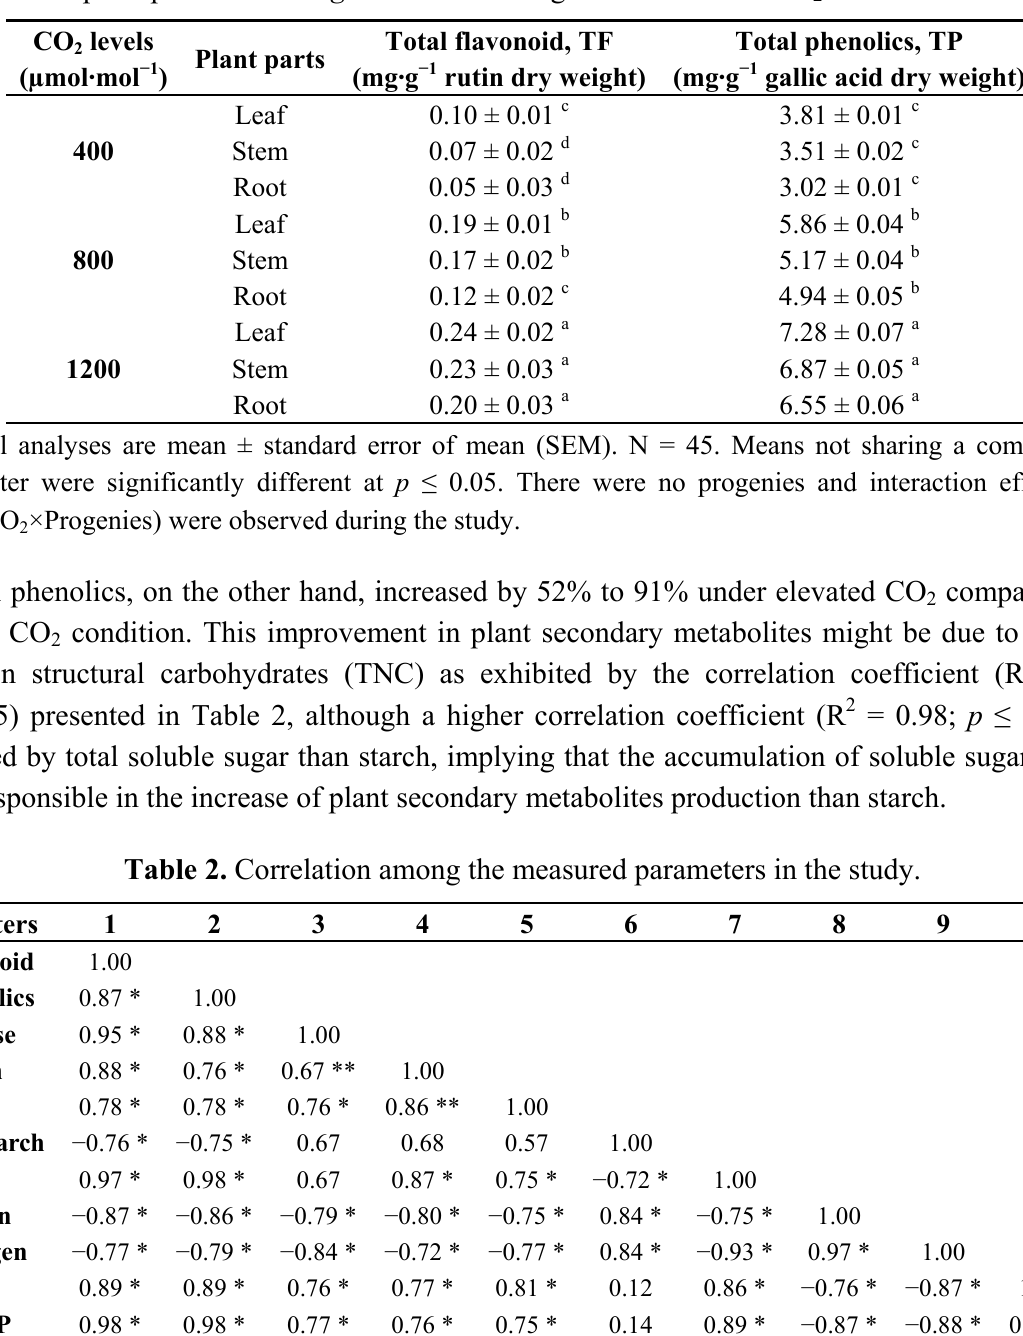
Table 1. Accumulation and partitioning of total flavonoids (TF) and total phenolics (TP) in different plant parts of Elaeis guineensis seedlings under different CO